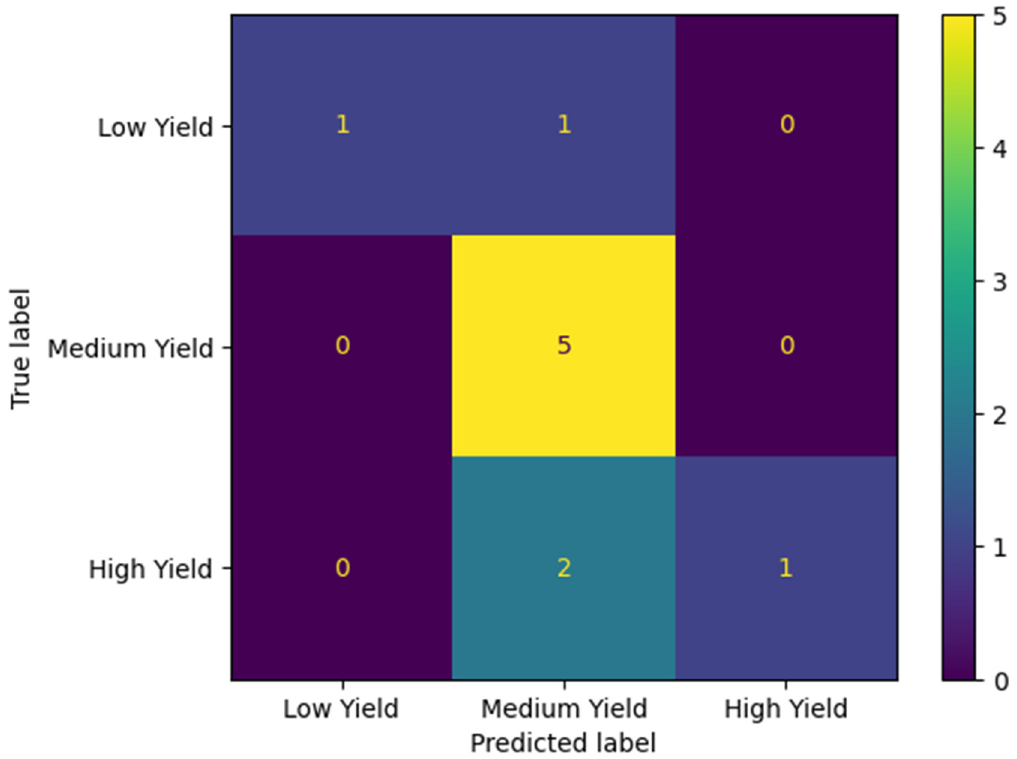
Figure 4. Confusion matrix for Table 7 best accuracy of 70.0% using XGB and TVAE with 5000